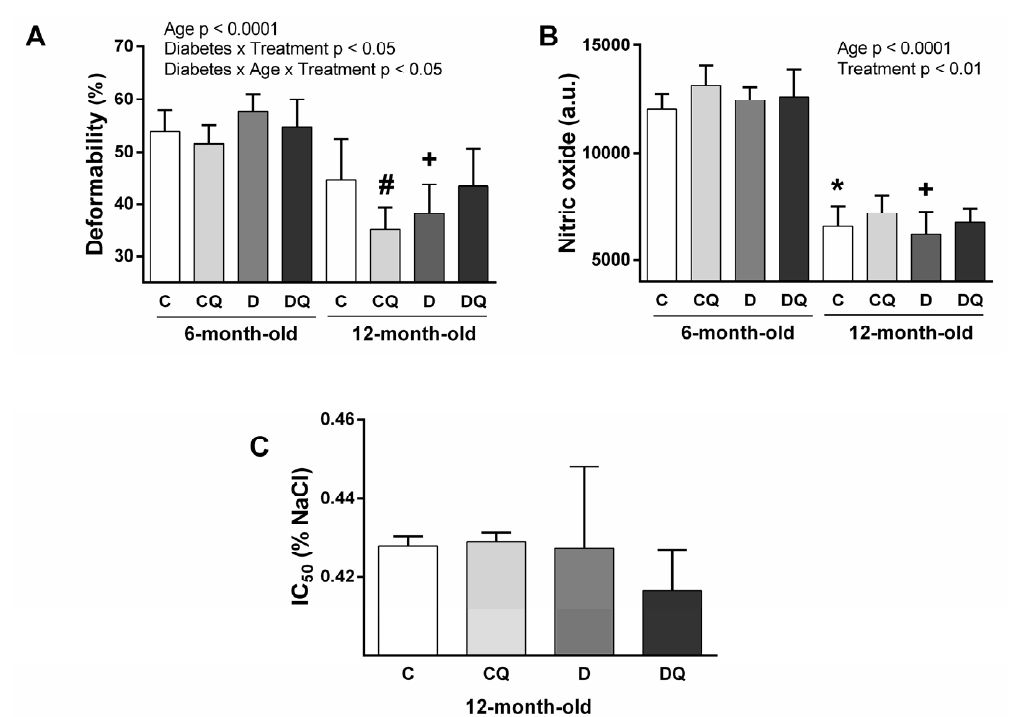
Figure 4. Parameters of erythrocytes: erythrocyte deformability ( A ), nitric oxide production by erythrocytes ( B ), osmotic resistance of erythrocytes determined by the concentration of NaCl providing 50% hemolysis—IC 50 ( C ). Abbreviations: C—lean control vehicle-treated, CQ—lean control quercetin-treated, D—Zucker diabetic fatty (ZDF) vehicle-treated, DQ—ZDF quercetin-treated. * p < 0.05 versus 6-month-old C group, + p < 0.05 versus 6-month-old D group, # p < 0.05 versus age-matched C group. Data are presented as means ± standard deviations.